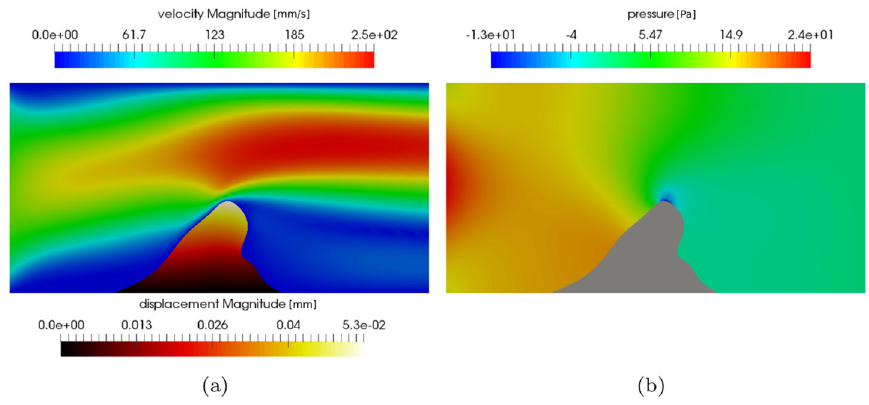
Fig. 3 Field solutions of the ground truth simulation with parameters x gt on the deformed geometry. a Fluid velocity magnitude, solid displacement magnitude. b Fluid pressure solution